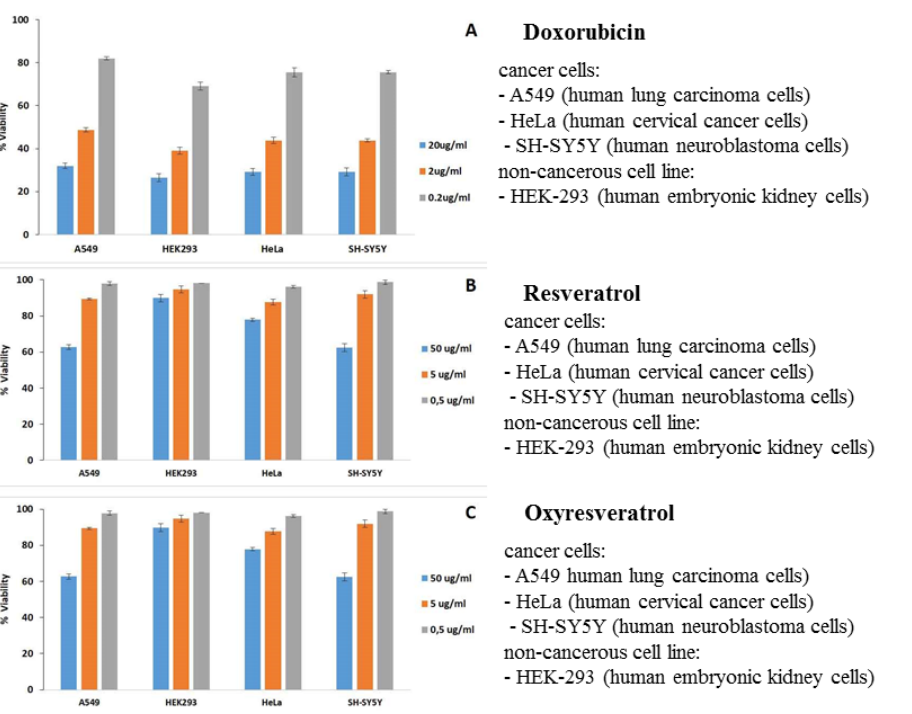
Figure 3: Viability of cancer and non-cancerous cell lines after compounds 4 (resveratrol) and 5 (oxyresveratrol) treatments for 48 h. Cell viability was determined by MTT assay, control was exposed to vehicle only which was taken as 100%